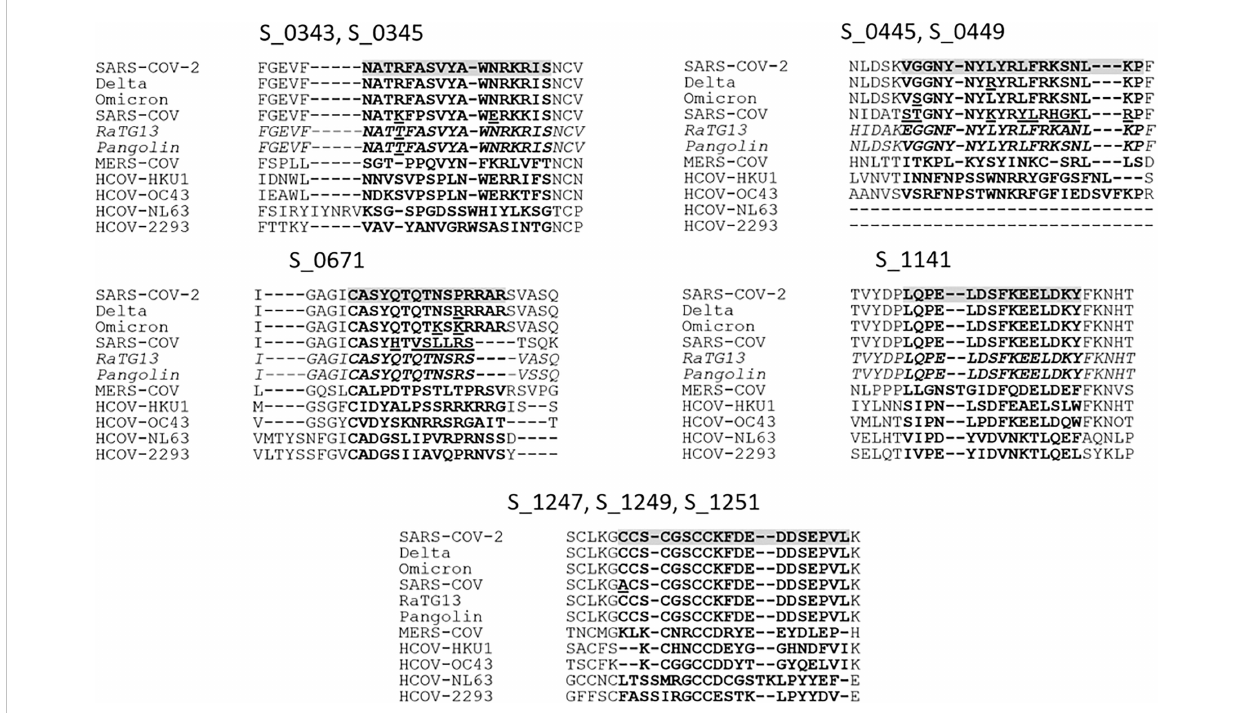
FIGURE 4 To determine the conservation of the potential epitopes, the Wuhan SARS-CoV-2 sequence was aligned with the Delta and Omicron variant sequences, closely related Pangolin and bat-infecting (RaTG13) coronaviruses, and human SARS-CoV, MERS-CoV, HCOV-HKU1, -OC43, -NL63, and -2293. Peptide IDs are displayed above corresponding alignments, and the epitopes are highlighted for SARS-CoV-2 with corresponding peptides in bold for all sequences, with notable deviations between similar sequences